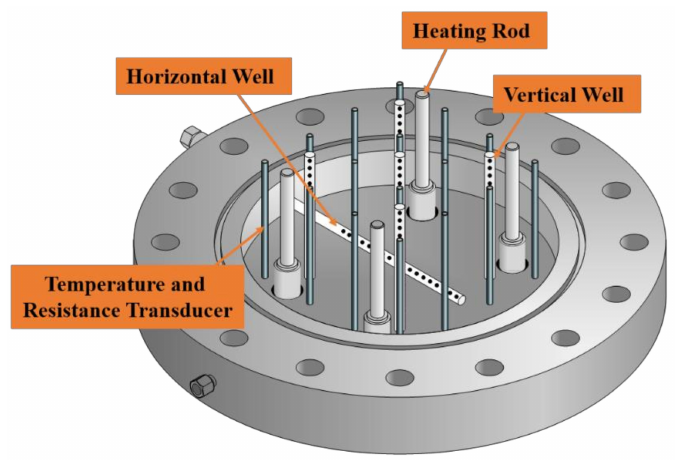
Figure 4. The bottom plate of the DLCS inserted with sixteen temperature and electric resistance transducers, five vertical wells, a horizontal well and four heating